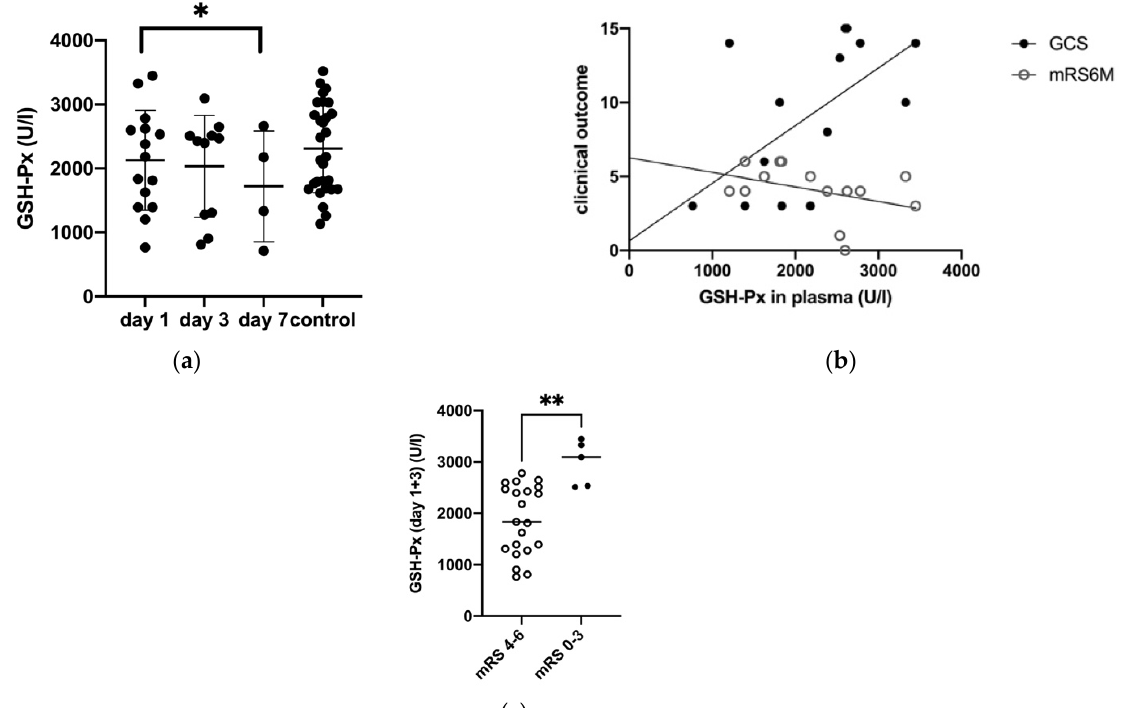
Figure 2. ( a ) Development of GSH-Px levels in plasma (P) in ICH patients and control group (day 1, day 3, and day 7), GSH-PX at day 1 and 7: p = 0.046 ( b ) Correlation of GSH-Px levels in plasma with mRS after 6 months ( p = 0.04) and with GCS in ICH patients ( p = 0.03) ( c ) Comparison of GSH-Px in P (day 1 and 3) of patients with a favorable (0–3) and an unfavorable (4–6) mRS after 6 months ( p = 0.002), ( p ≤ 0.05 *, p < 0.01 **).